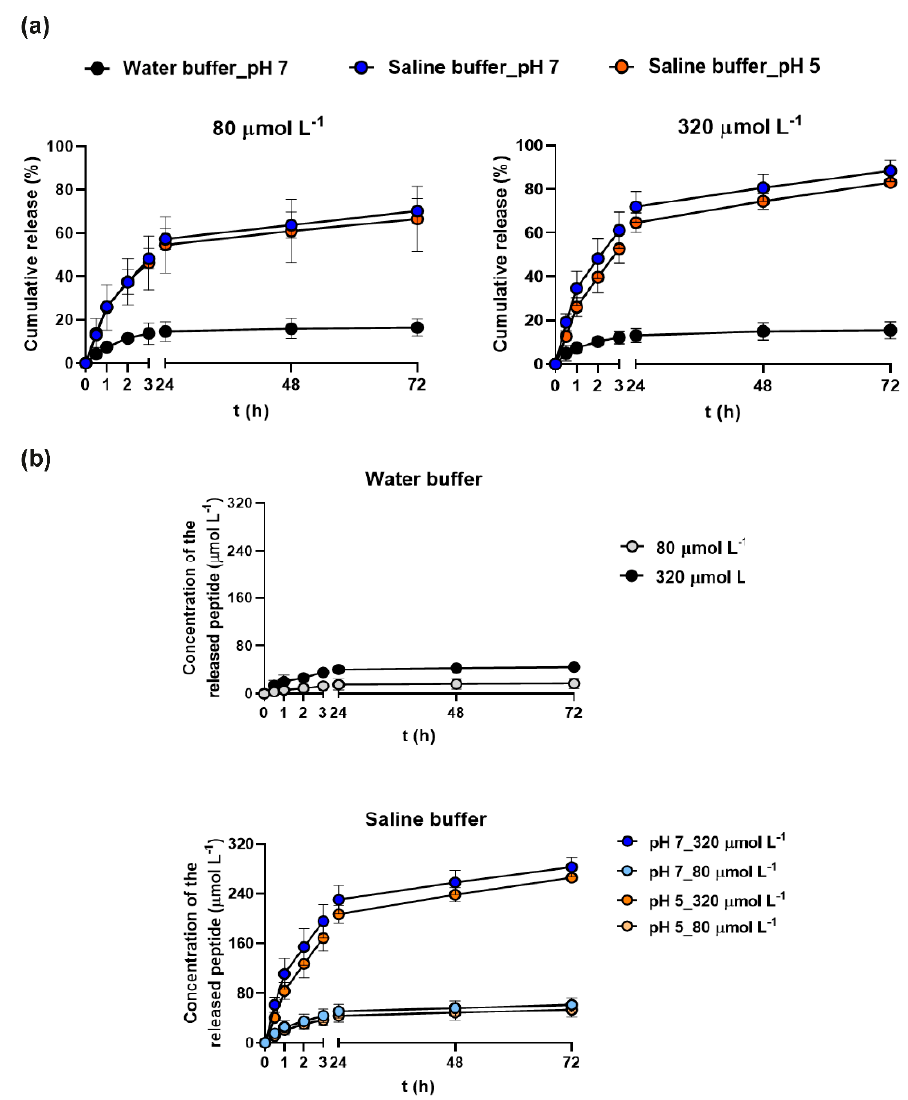
Figure 5. In vitro peptidomimetic release profile. ( a ) Evaluation of the amount of the peptidomimetic released from HA-BDDE loaded with two different (ri)-r(P)ApoB SPro concentrations, i.e., 80 or 320 µmol L − 1 . ( b) Cumulative release of (ri)-r(P)ApoB SPro expressed as percentage with respect to the total initial amount of peptidomimetic filled into gel.